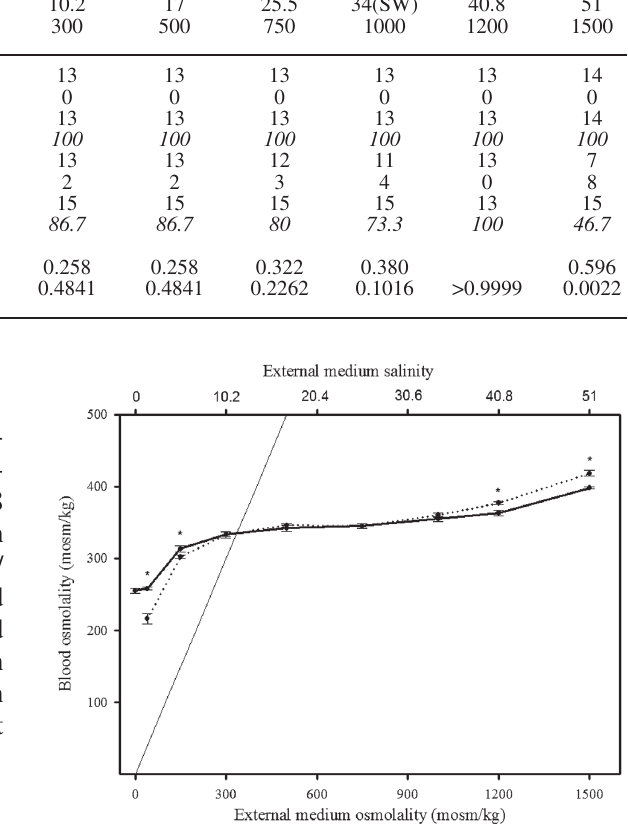
Fig . 2. – variations in blood osmolality in Pomatoschistus microps (plain line) and P. marmoratus (broken line) in relation to the osmo- lality/salinity of the external medium, following 4 day-exposure at 20°C. data are presented as means ± standard deviation (n = 9-10). As a reference, the isoconcentration line is drawn, passing by the origins of both axes. *: significant differences between the two spe- cies at this